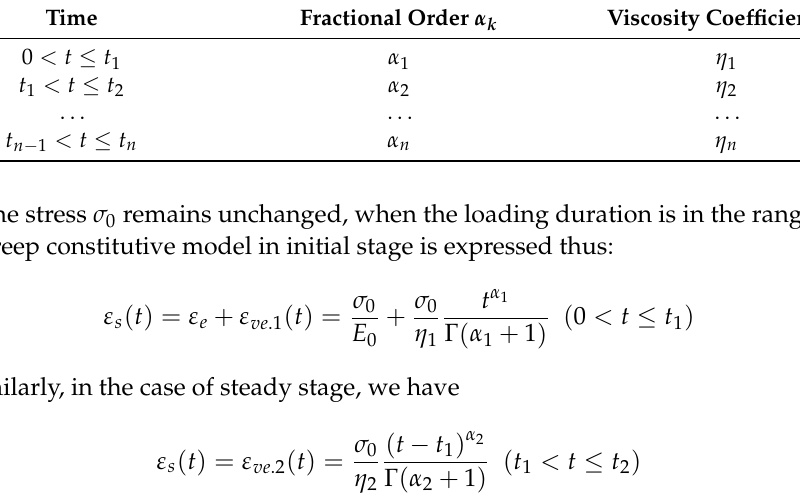
Table 1. Values of fractional order α k and viscosity coefficient η k versus time.